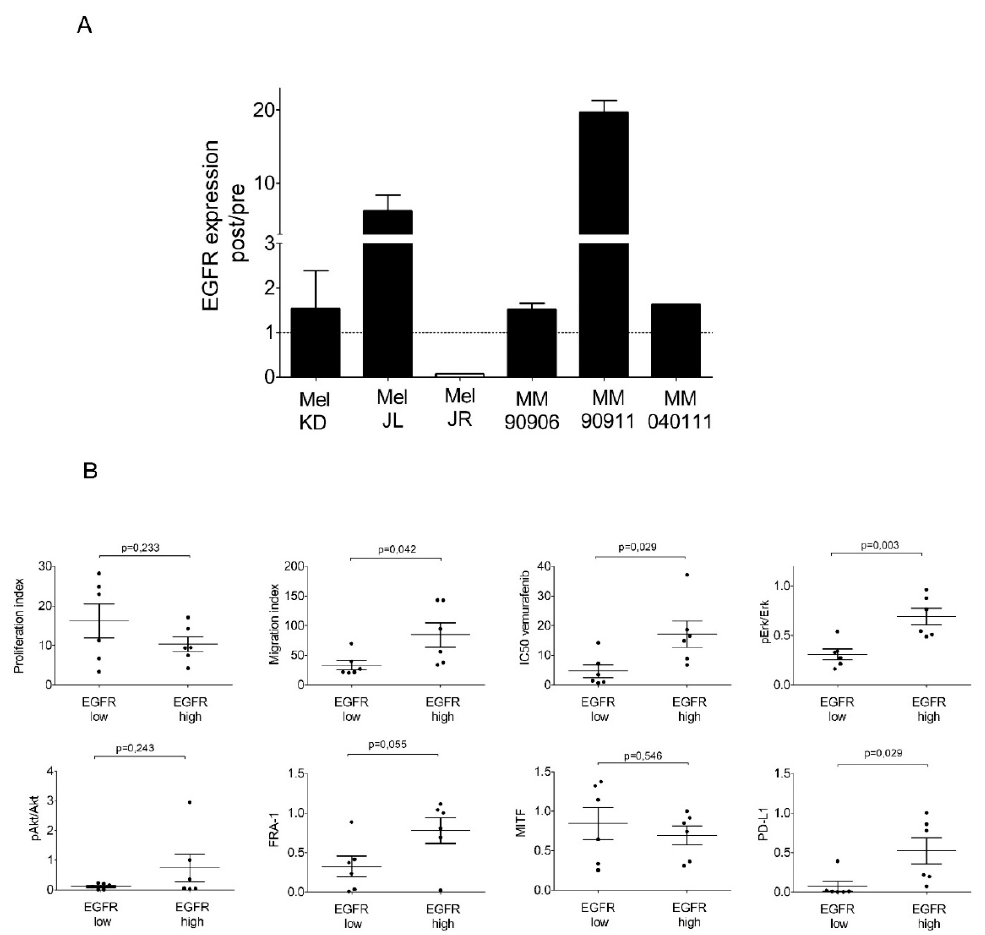
Figure 4. The impact of EGFR expression in V600E BRAF-mutant melanoma cells. ( A ) EGFR expression was elevated in five out of six cell line pairs. ( B ) EGFR-high melanoma cell lines showed significantly higher migration index, vemurafenib IC50 values, pErk / Erk ratio, and FRA-1 and PD-L1 expression.